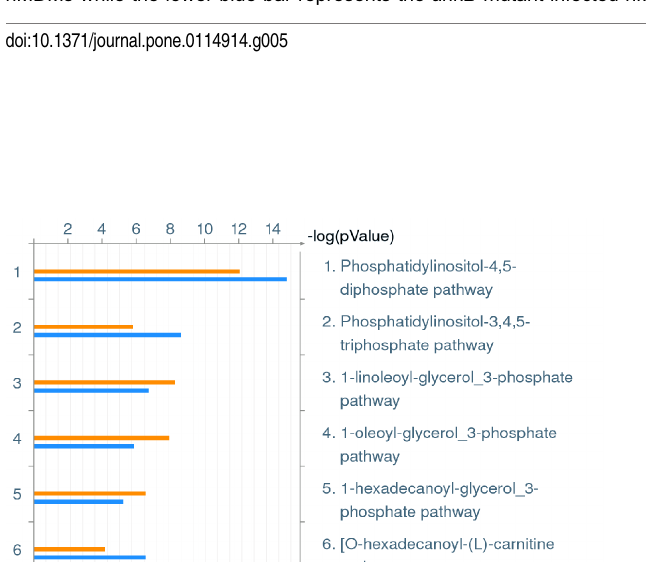
Figure 5. Top 10 Metabolic Pathways up-regulated in hMDMs upon infection by L. pneumophila . Meta- ankB mutant-infected hMDMs 8 h post-infection showing the top 10 Metabolic Pathways. The upper orange bar of each column represents wild type-infected hMDMs while the lower blue bar represents the ankB mutant-infected hMDMs.